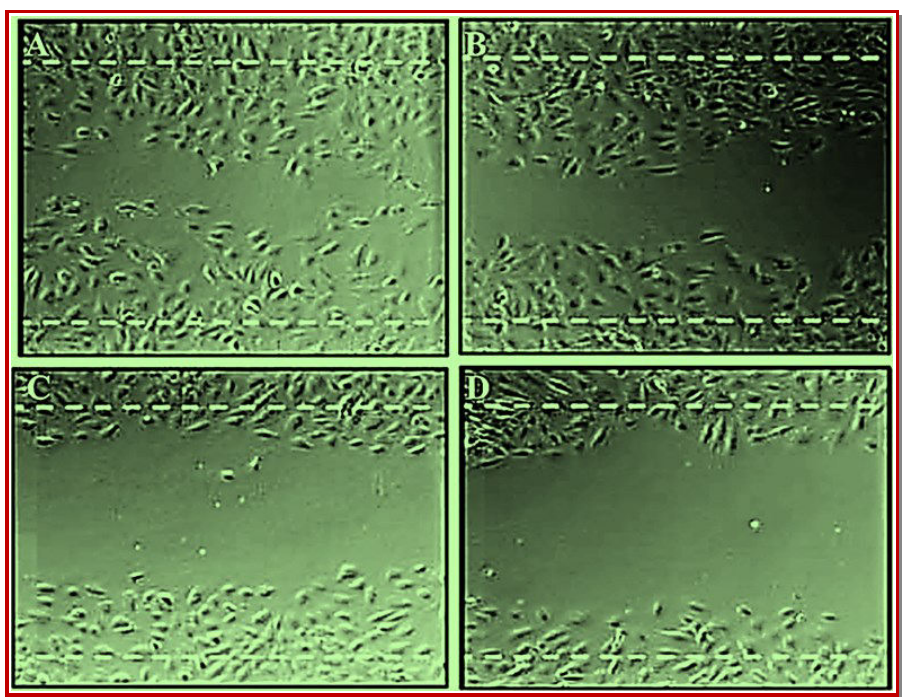
Figure 2: Inhibition of cancer cell migration in MG-63 human osteosarcoma cells induced by caryophyllene oxide. Phase contrast microscope was used for capturing images after the cells were treated with 0 (A), 20 (B), 80 (C) and 120 (D) µM dose of caryo- phyllene oxide for 48 hours